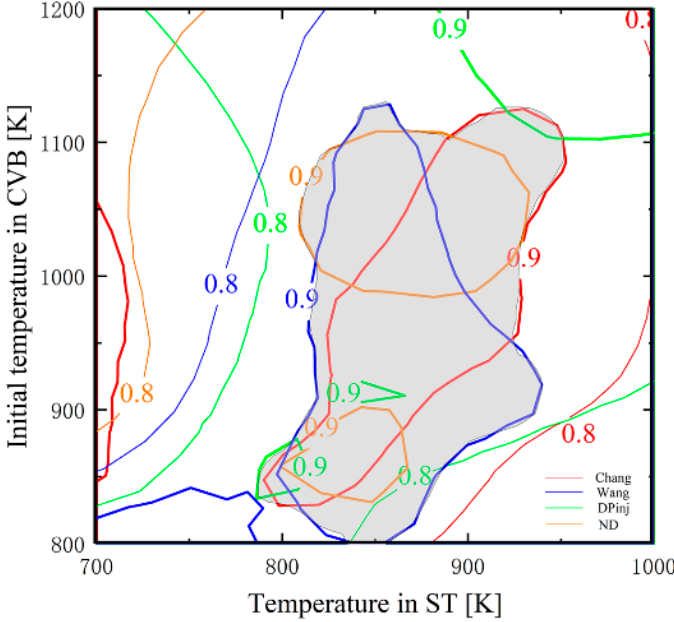
Figure 12. Similarity factors between CVB and ST under different conditions .